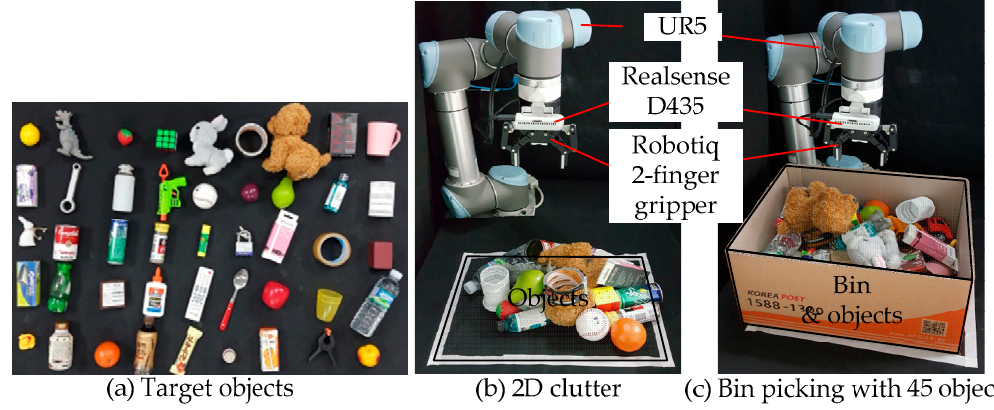
Figure 8. ( a ) Target objects; ( b ) grasping in 2D clutter; ( c ) grasping in 3D bin.